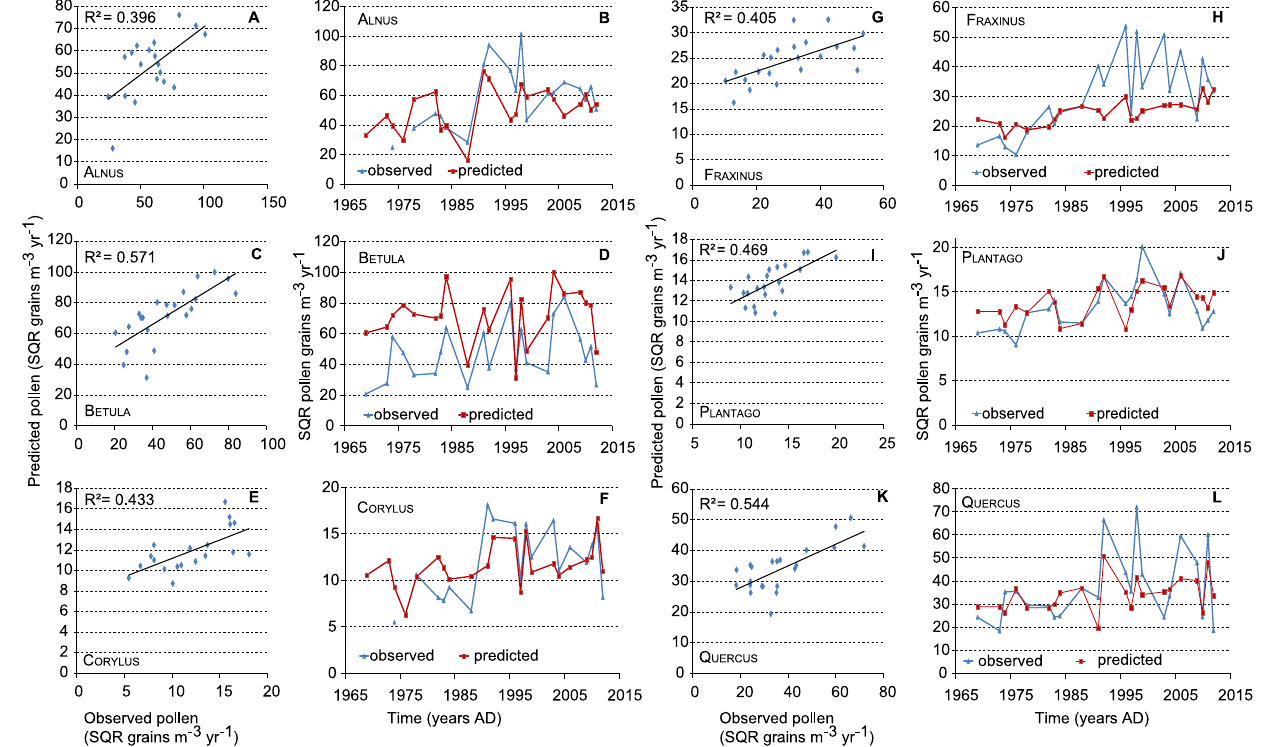
Figure 5. Observed versus climate predicted LUMC pollen influx based on the split data sets. Values are shown for (a,b) A LNUS , (c,d) B ETULA , (e,f) C ORYLUS , (g,h) F RAXINUS , (i,j) Q UERCUS , and (k,l) P LANTAGO .